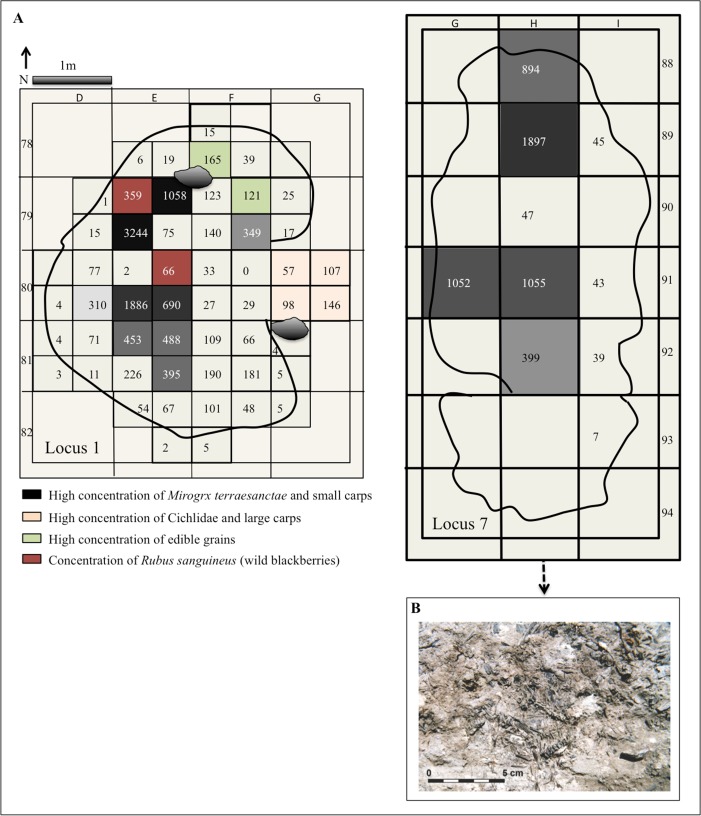
A. Fish remains spatial distribution pattern in Loci 1 (floors I and II combined) and 7 (in Locus 1 areas with a large concentration of edible grains from floor II are marked, after [40]; B. In-situ fish skeletons recovered at Locus 7.